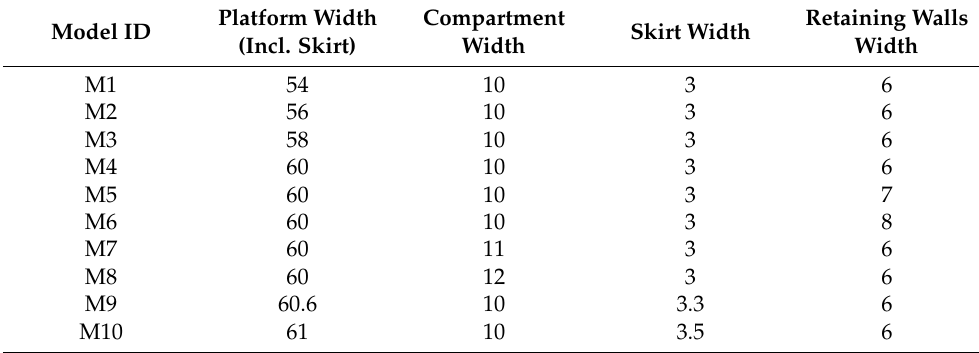
Table 2. Main dimensional information about the considered different platforms for the initial selection of the barge (unit: